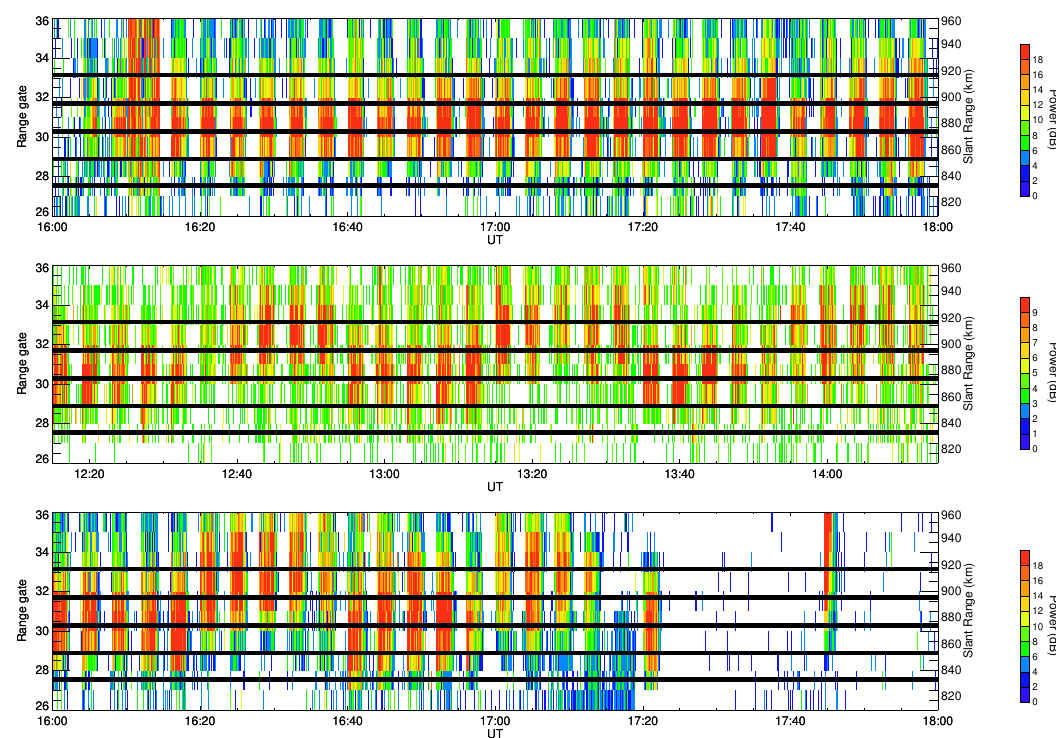
Fig. 8. CUTLASS backscatter powers, together with overlaid UHF positions, obtained for ( a ) 16:00–18:00 UT on 25 September 2002, ( b ) FA − 12 are shown using the horizontal yellow lines and correspond to decreasing range gate and slant range. The backscatter powers are only high in the directions in which the heater points, vertical and